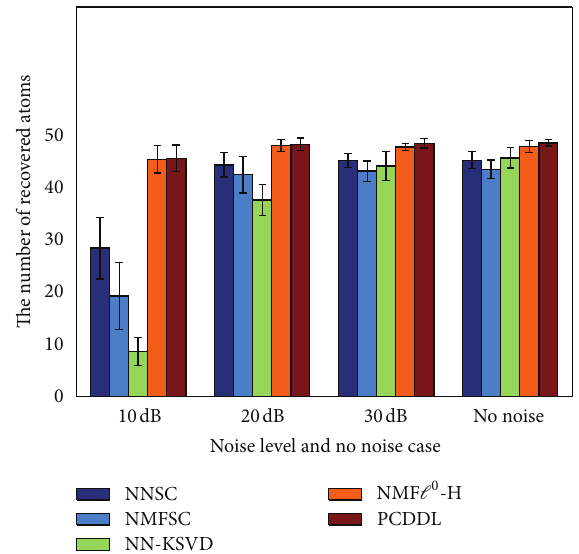
Figure 4: Results of a synthetic experiment with a dictionary of size 20 × 50. For each of the tested algorithms and for each noise level, 15 trialswereperformed. Averaged values oflearned atomsand corresponding deviation values are displayed.